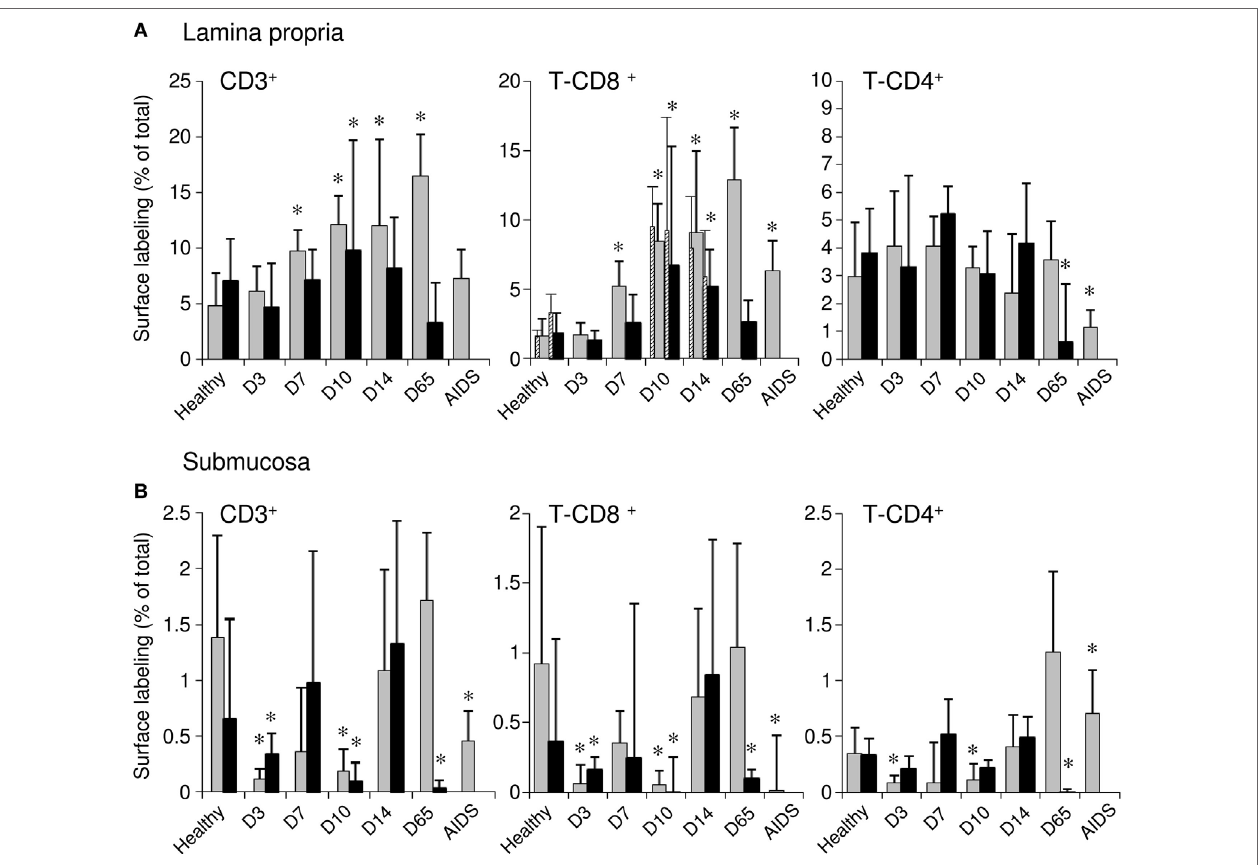
FigUre 5 | changes in the cD4 + and cD8 + T-cell compartments in the ileum during simian immunodeficiency virus infection . Ileal tissues sampled from healthy animals as well as from macaques euthanized at 3, 7, 10, 14, or 65 days post-SIV infection (two animals per time point), and from one animal presenting with AIDS-related symptoms, were labeled using anti-CD3 and anti-CD4 antibodies. The proportions of lamina propria [LP; (a) ] or submucosa [SM; (B) ] tissues occupied by the CD3 + , CD3 + CD4 − (T-CD8 + ), and CD3 + CD4 + (T-CD4 + ) labeled cells are represented as medians and SDs for each time point. For each animal, 5–10 independent areas, representing at least 1.5 mm 2 of LP or 1.4 mm 2 of SM, were quantified. Hatched bars on the T-CD8 + graph [ (a) , central panel] represent quantifications of CD3 + CD8 + cells (labeled with anti-CD3 and anti-CD8 antibodies) performed on tissues sampled on days 0, 10, or 14 pi. Statistical analysis was performed for each infected macaque, compared individually to each healthy control. A given subset was considered as over/under represented in one infected macaque if significantly different from both healthy controls, tested independently (* p < 0.05 as compared to each uninfected monkeys; Mann–Whitney two-tailed U